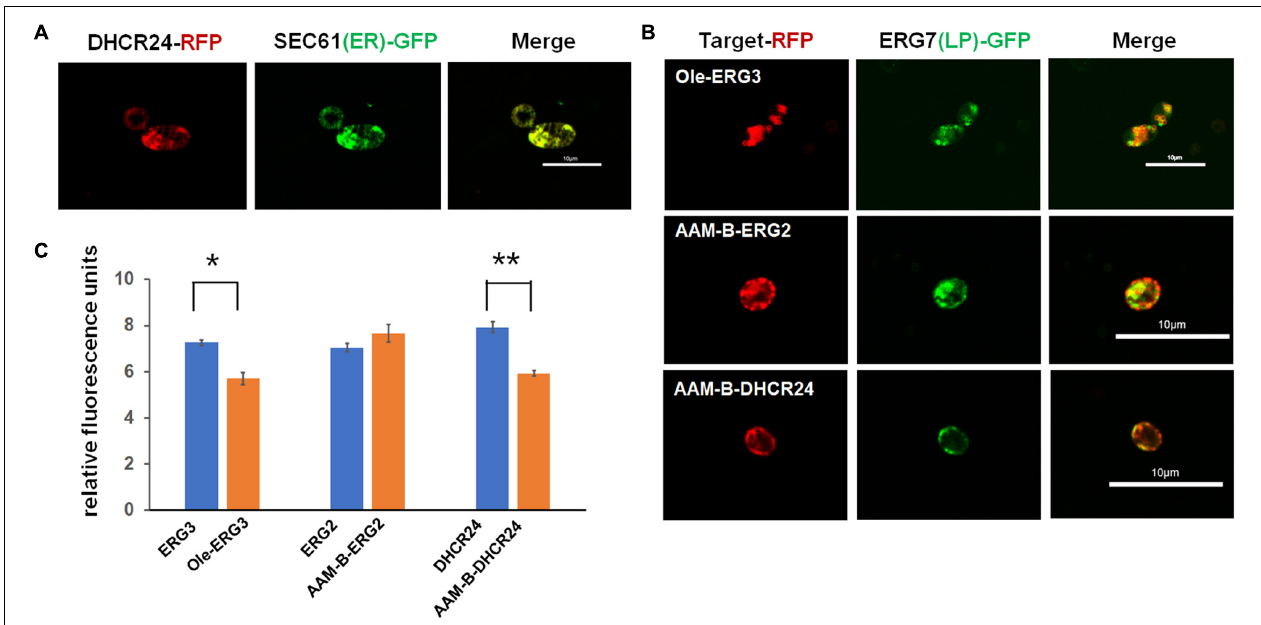
FIGURE 2 | Identifying the subcellular localization of gallus DHCR24 and verifying the reported LD localization sequence in S. cerevisiae . (A) Analysis of subcellular localization of gallus DHCR24 in S. cerevisiae . Sec61 is the specific marker of yeast ER. (B) Analysis of subcellular localization of two LD tags including oleosin (Ole) and AAM-B. ERG7 is the specific marker of yeast LDs. (C) Measurement of the expression levels of ER-/LD-located protein. Their expression levels were determined by the relative fluorescence units (RFU) of RFP fused with the enzymes. Significance levels of t -test: * P < 0.05, ** P <